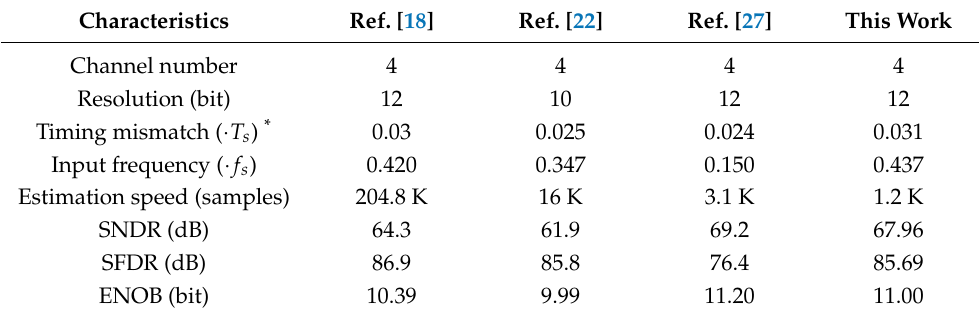
Table 2. The performance comparison results.